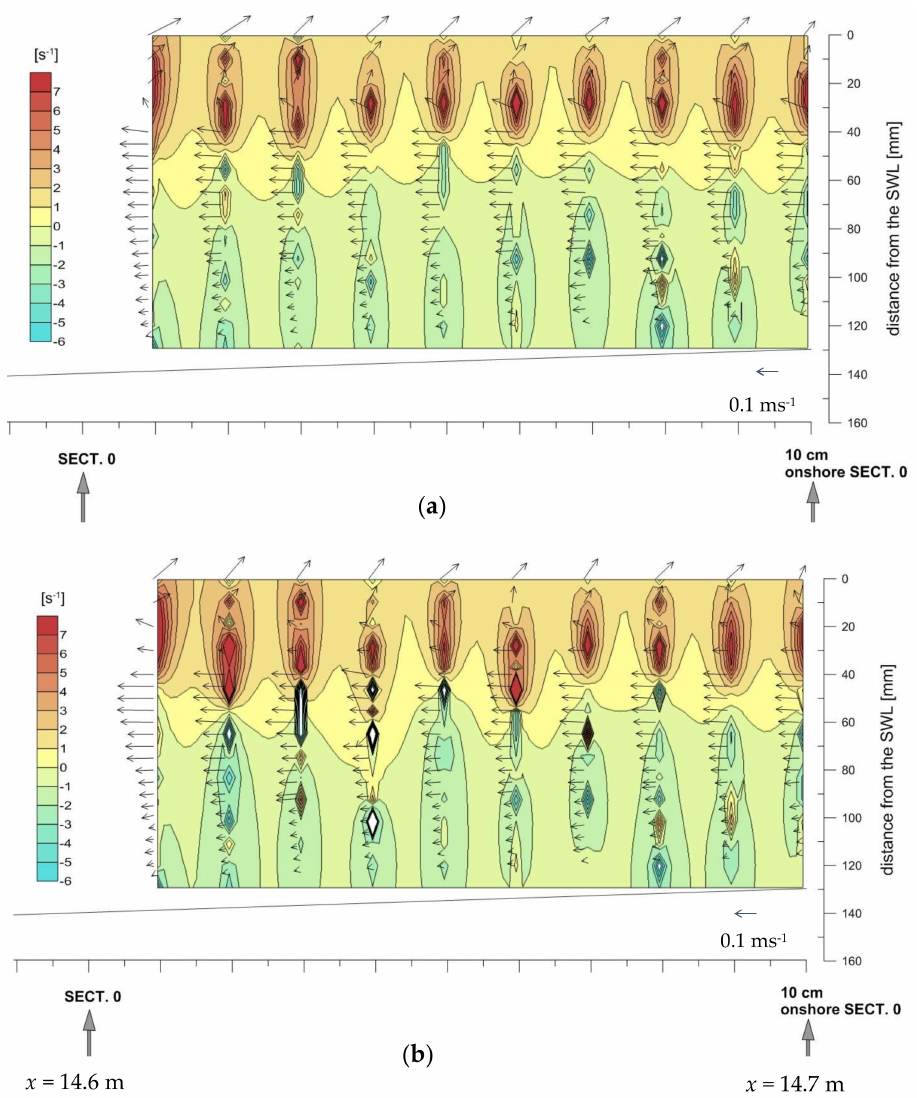
Figure 7. ( a ) Experimental and ( b ) numerical mean velocity vertical profiles superposed to the map of the mean vorticity. Values of the x coordinates are given with reference to the numerical wave paddle (see Section